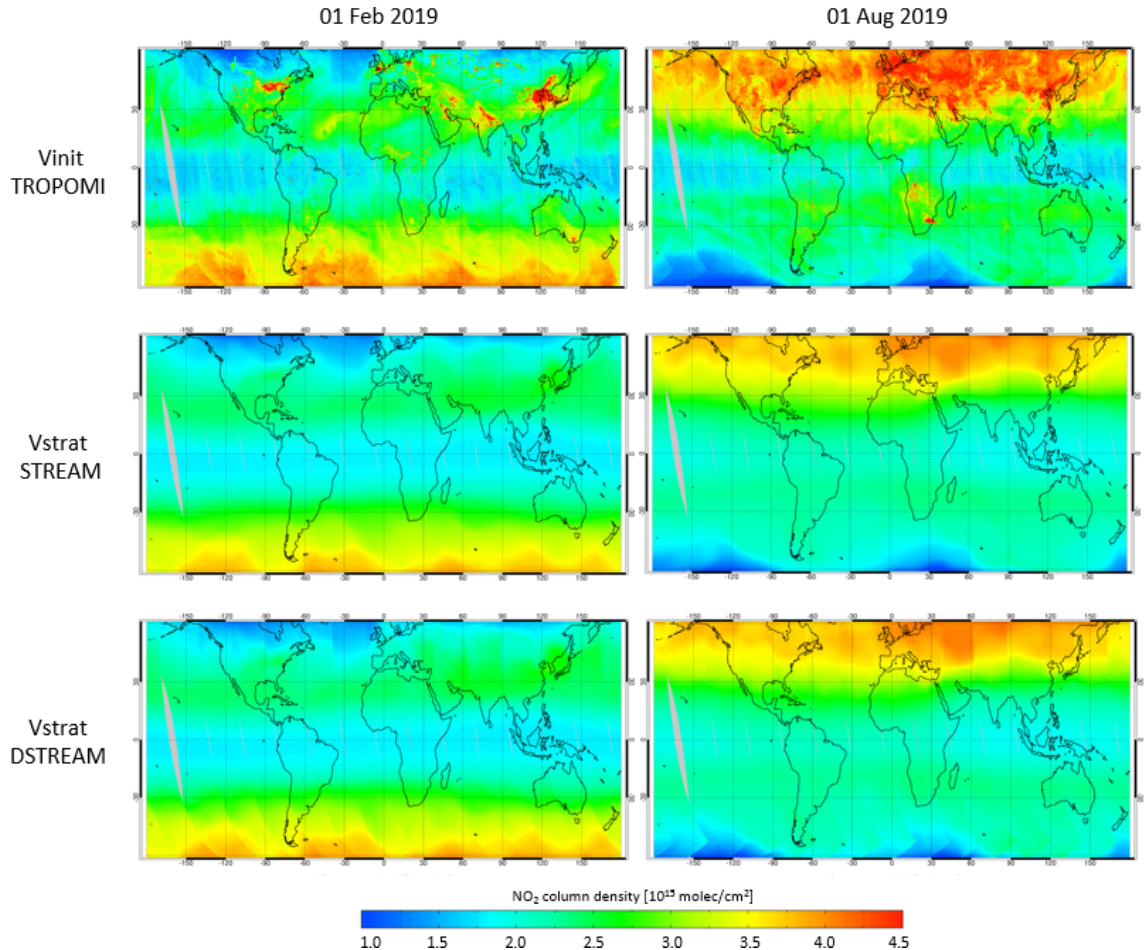
Figure 5. Total NO 2 columns and stratospheric NO 2 columns estimated using STREAM and DSTREAM, as measured by TROPOMI on 1 February and 1 August